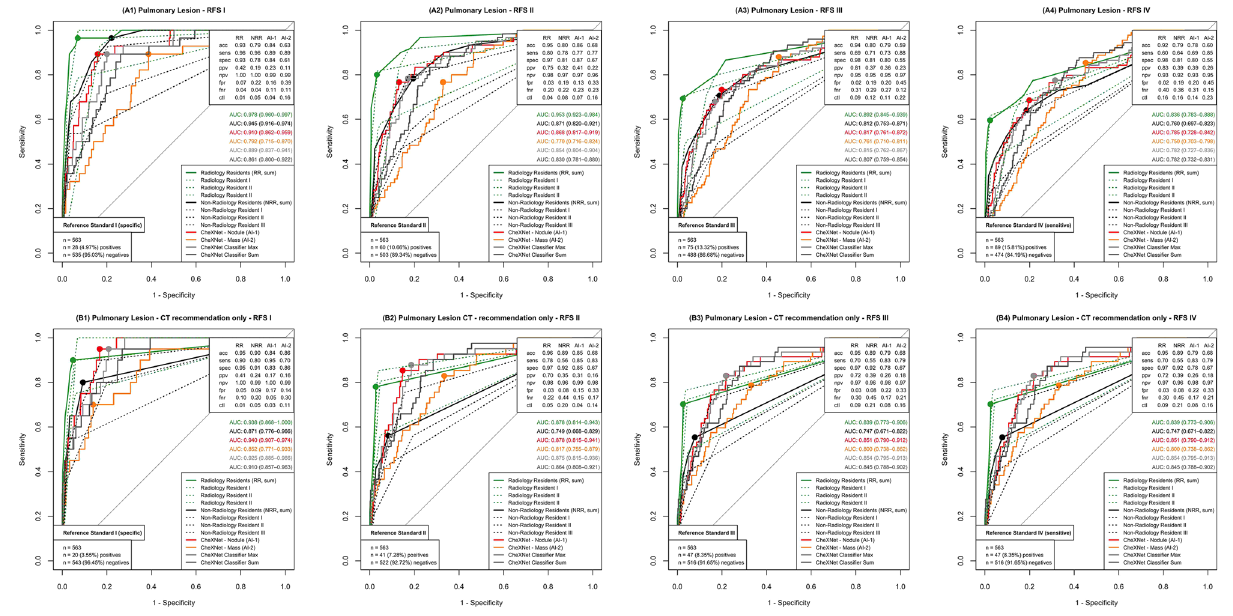
Figure 4. Benchmarking of (suspicious) pulmonary lesion detection; Performance results in CXR EU cohort for all four RFS (RFS I–IV) are displayed for pulmonary lesion detection in general ( A1 – A4 ) and for suspicious pulmonary lesions when CT was recommended by CXR readers ( B1 – B4 ). RR, NRR and classifiers “Nodule” and “Mass” performance is displayed as ROC curves. Classifiers “Max” and “Sum” represent the combination of two CheXNet classifiers (maximum output and sum of the outputs). In the clinically most relevant RFS IV classifier “Nodule” performed slightly better than NRR consensus ( A4 ) and could even beat (not statistically significant) RR consensus AUC in the detection of the potentially suspicious pulmonary lesions ( B4 ). Classifier “Mass” performed slightly better than the NRR consensus detecting potentially suspicious lesions ( B4 )